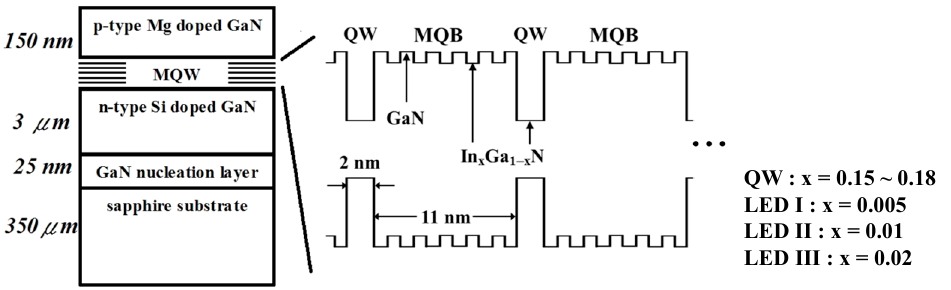
Figure 1. Schematic representation of the structure of the InGaN/GaN multiple quantum-well light-emitting diodes possessing different composition MQBs.